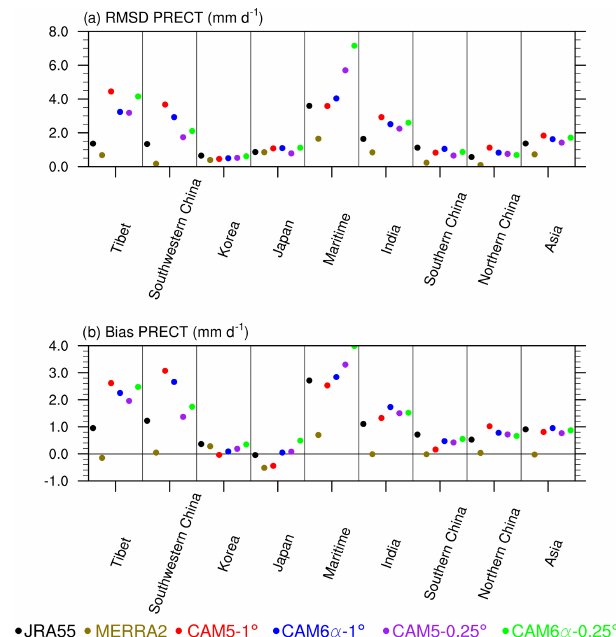
Figure 3. The root mean square difference (RMSD) and bias of annual mean precipitation (PRECT, mmd − 1 ) relative to APHRODITE for JRA55, MERRA2, CAM5-1 ◦ , CAM6 α -1 ◦ , CAM5-0.25 ◦ and CAM6 α -0.25 ◦ over six regions: Tibet: 27–37 ◦ N, 79–99 ◦ E; southwestern China: 28.5–35.5 ◦ N, 100–105 ◦ E; Korea: 34–40 ◦ N, 124.5–129.5 ◦ E; Japan: 31–43 ◦ N, 130–144 ◦ E; Mar- itime: 9.75 ◦ S–19.75 ◦ N, 90–150 ◦ E; Asia: 5–55 ◦ N, 60–140 ◦ E. Three other domains follow the geographical boundary and climatic zones for India, northern China and southern China as in Lin et al. (2018). The India average is entirely within mainland India. The western boundary of northern China and southern China is a straight line (shown in Fig. 2c) called the Hu–Huanyong line between Heihe (50.2 ◦ N, 127.5 ◦ E) and Tengchong (24.5 ◦ N, 98.0 ◦ E). The separa- tion of northern China and southern China (shown as the straight line in Fig. 2c) is along the latitude of Qin Mountain and the Huai River (32.8 ◦